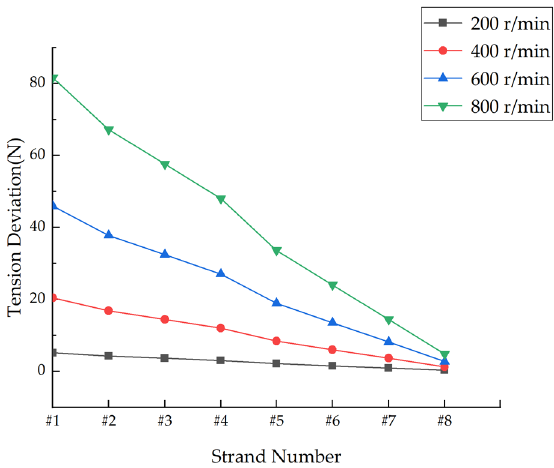
Figure 4. T ension deviation of each strand at different rotatio nal